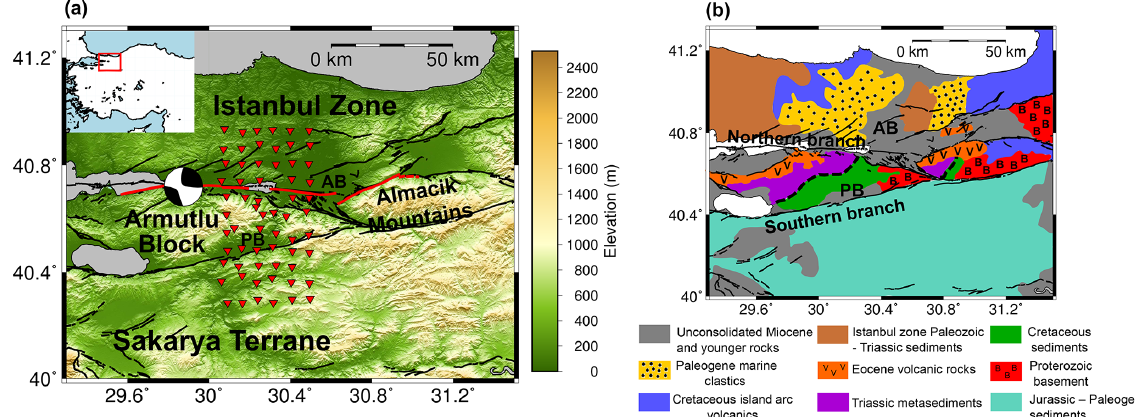
Figure 1. (a) Overview of the Izmit–Adapazari region and the DANA network. Stations of the DANA network are shown as red triangles; station names are of the form Dx01 to Dx11, where x is A through F from west to east and 01 is at the southern end of each line. Thick black lines identify mapped faults in the region (Emre et al., 2016). The thick red line indicates the extent of the rupture of the 1999 Izmit and Düzce earthquakes (Barka et al., 2002). The epicentre and focal mechanism for the Izmit earthquake provided by the GCMT catalogue (Dziewonski et al., 1981; Ekström et al., 2012) are shown. Topography data were acquired by the Shuttle Radar Topography Mission (USGS, 2006). (b) Geological map of the Izmit–Adapazari region simplified from Akbayram et al. (2016). The locations of the southern and northern branches of the North Anatolian Fault zone are indicated. The black dashed line shows the location of the Intra-Pontide suture within the Armutlu Block inferred by Akbayram et al. (2016). AB and PB show the location of the Adapazari and Pamukova basin, respectively.